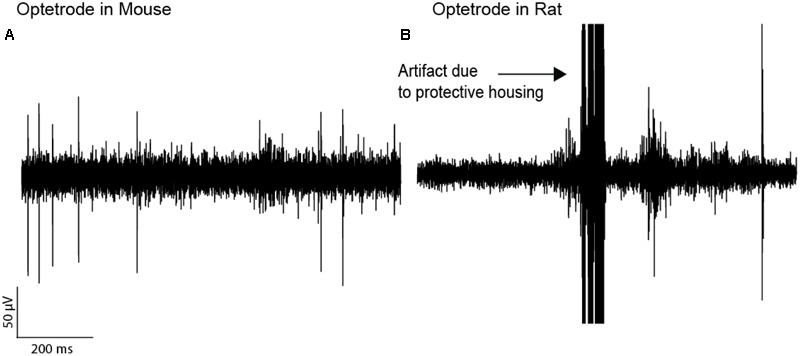
Optetrode recordings are more stable in mice than in rats. (A) A trace of electrophysiological recordings in a mouse implanted with an Optetrode drive. (B) Recordings in a rat with the Optetrode drive surrounded by the protective housing. The arrow indicates the artifact which were caused by the rat hitting the metal wall with the protective housing when entering the reward port.